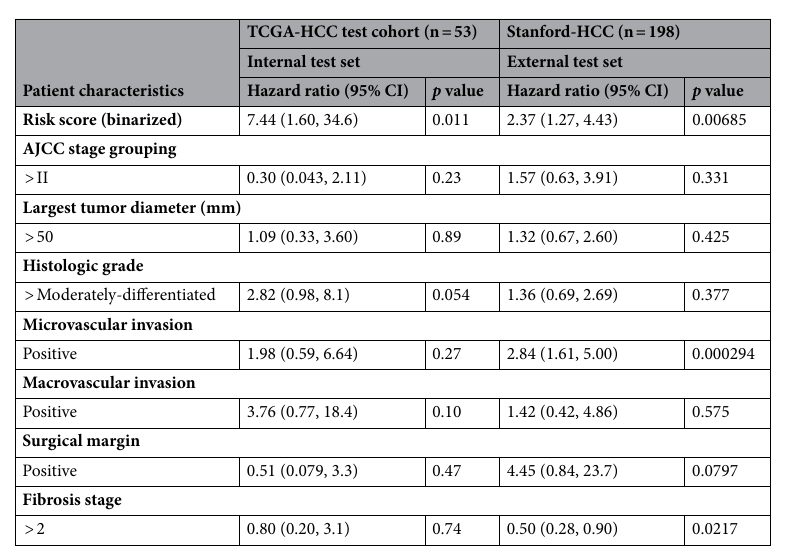
Table 3. Multivariable Cox proportional hazards analysis of the risk of recurrence. CI, confidence interval.